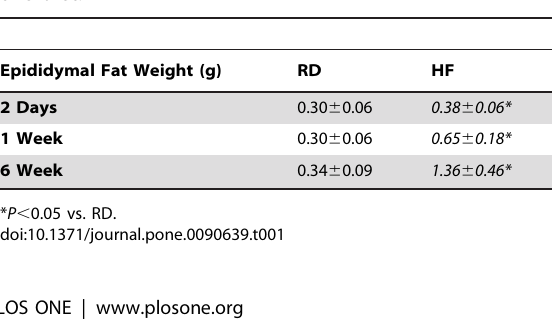
Table 1. High Fat diet leads to a significant expansion of epidydimal fat after 1 and 6 weeks compared to RD controls, demonstrating the rapid accretion of adiposity in mice fed this